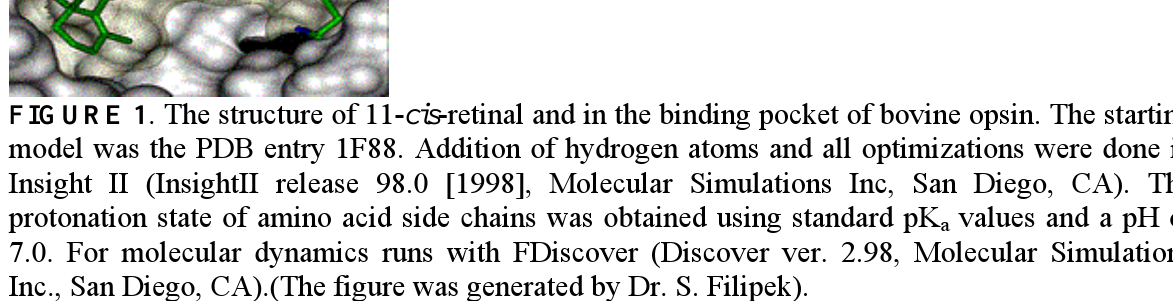
values and a pH of a